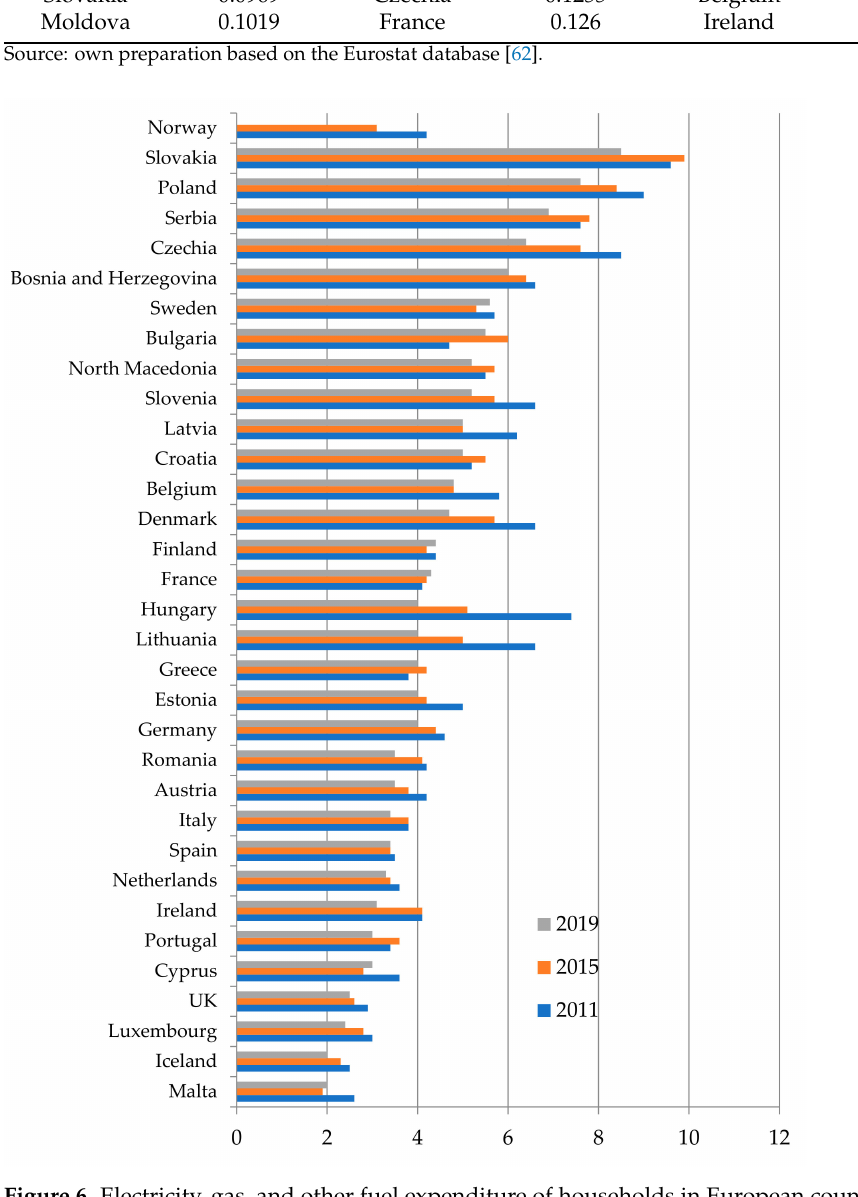
Figure 6. Electricity, gas, and other fuel expenditure of households in European countries in 2011, 2015, 2019 (in %). (2019, Norway there are no data; 2011, 2015, 2019, Kosovo, Albania, Montenegro there are no data). Source: own preparation based on Eurostat database